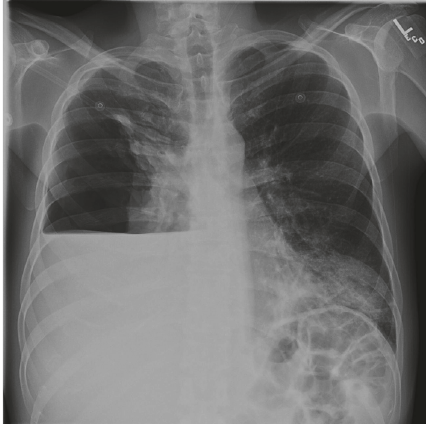
Figure 2: Chest X-ray after thoracentesis showing large right pneumothorax with collapse of the lung into the hilar region. Large right hemithorax air-fluid level. Increased airspace consolidation within the left lower lobe.